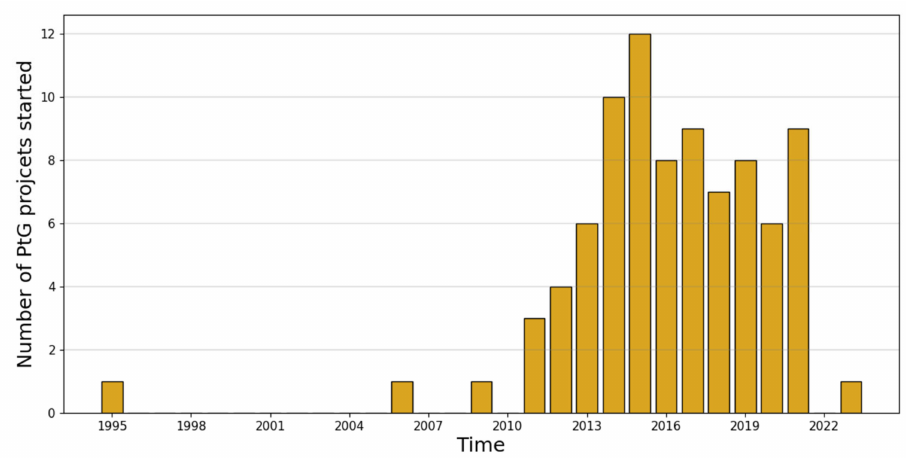
Figure 1. Power-to-gas projects grouped per start date.